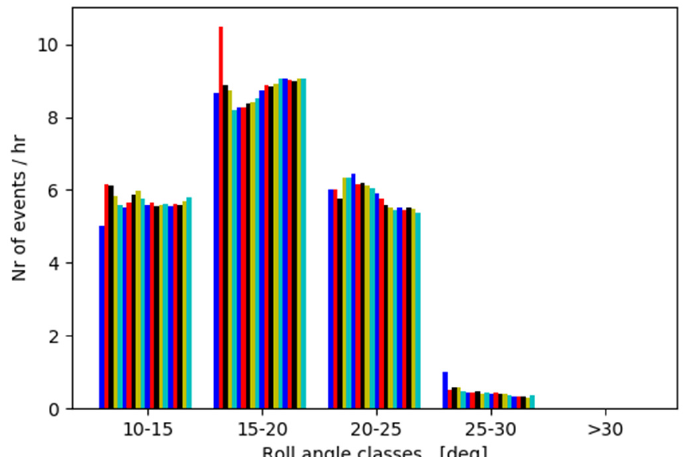
Figure 3. Ensemble statistics of the number of parametric roll events classified in different groups on the basis of the maximum roll angle in each event. The plot shows successive results 3 h, 6 h, 9 h, etc of simulations, with a maximum of 60 h. Sea state: Hs = 7 m, Tp = 13.5 s, speed Vs = 7.6 kn.